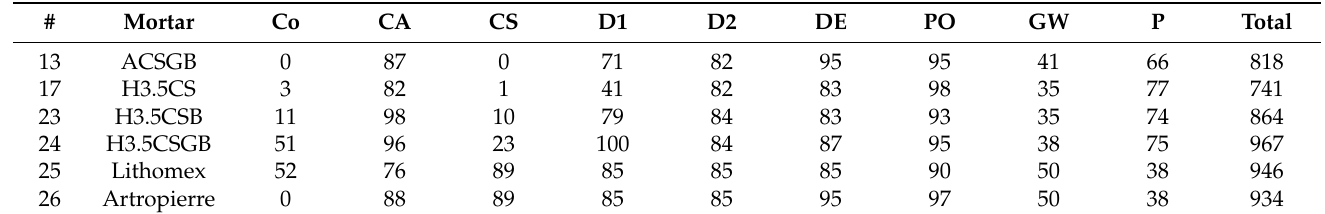
Table 15. Scores for selected mortars for the Oxpemul stone with weighed coefficients (Equation